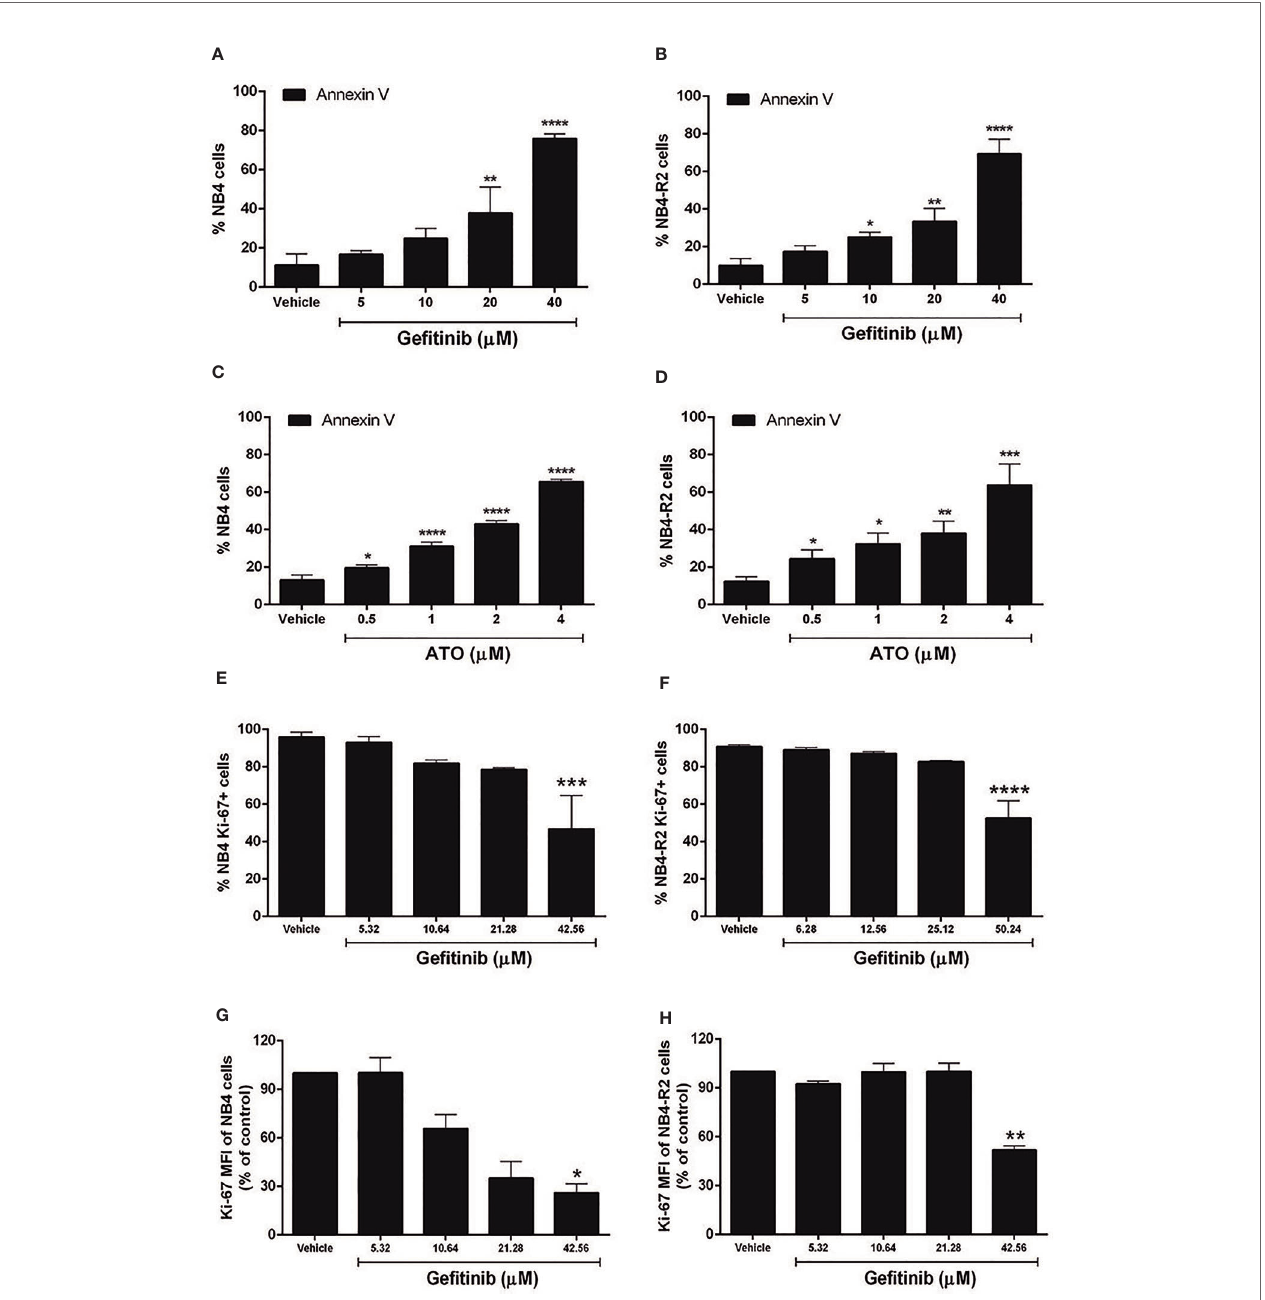
FIGURE 2 | Effects of ge fi tinib or ATO monotherapy on APL cell apoptosis and proliferation. Ge fi tinib (5, 10, 20, and 40 m M) (A, B) and ATO (0.5, 1, 2, and 4 m M) (C, D) treatment for 24 h decreased the fraction of apoptotic NB4 and NB4-R2 cells in a concentration-dependent manner, as determined by Annexin V/PI staining and fl ow cytometry analysis. Proliferation of NB4 (E) and NB4-R2 (F) cells was reduced at ge fi tinib concentrations higher than twice the ED 50 after 24 h of treatment. (G, H) MFI values for NB4 and NB4-R2. Bar graphs show mean ± SD of at least three independent experiments. (*) p < 0.05, (**) p < 0.01, (***) p < 0.001, (****) p < 0.0001 (Kruskal – Wallis test, followed by Dunn ’ s post hoc